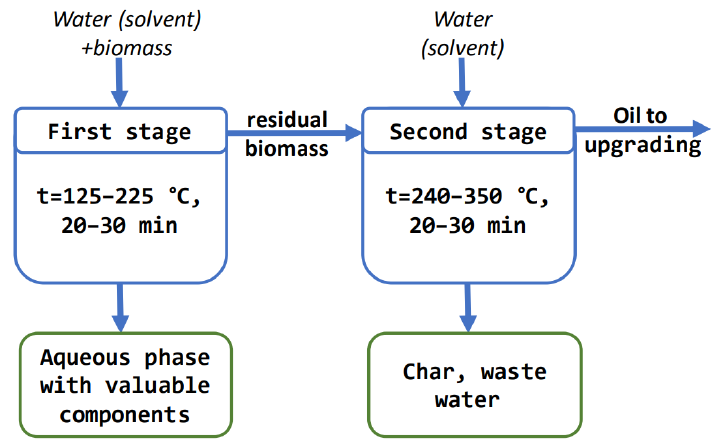
Figure 1. Scheme of carrying out a two-stage HTL